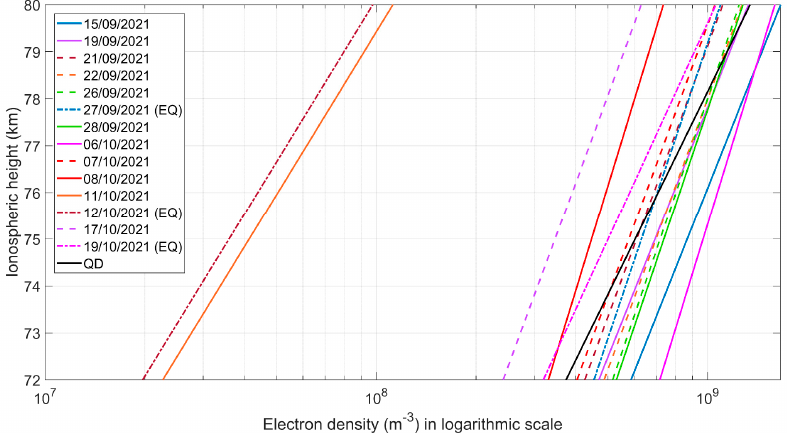
Figure 10. Same as Figure 9 for SST1 of ISR–UWA path.